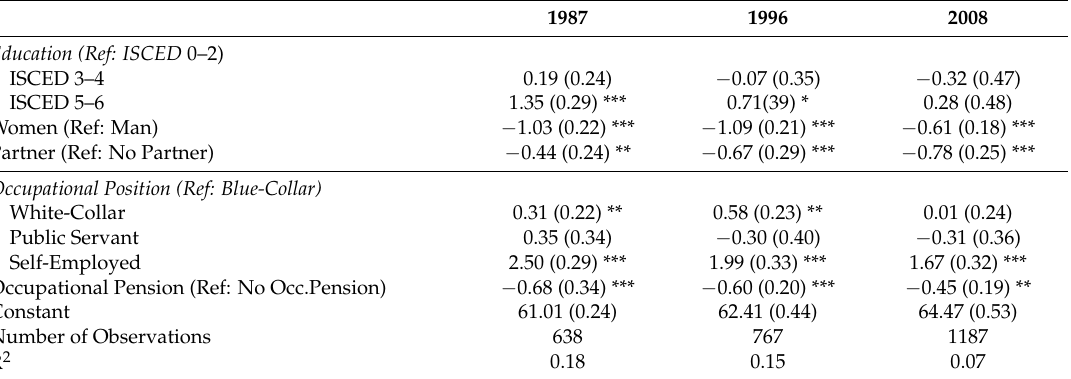
Table 1. The Relation of Education and Expected Retirement Age.